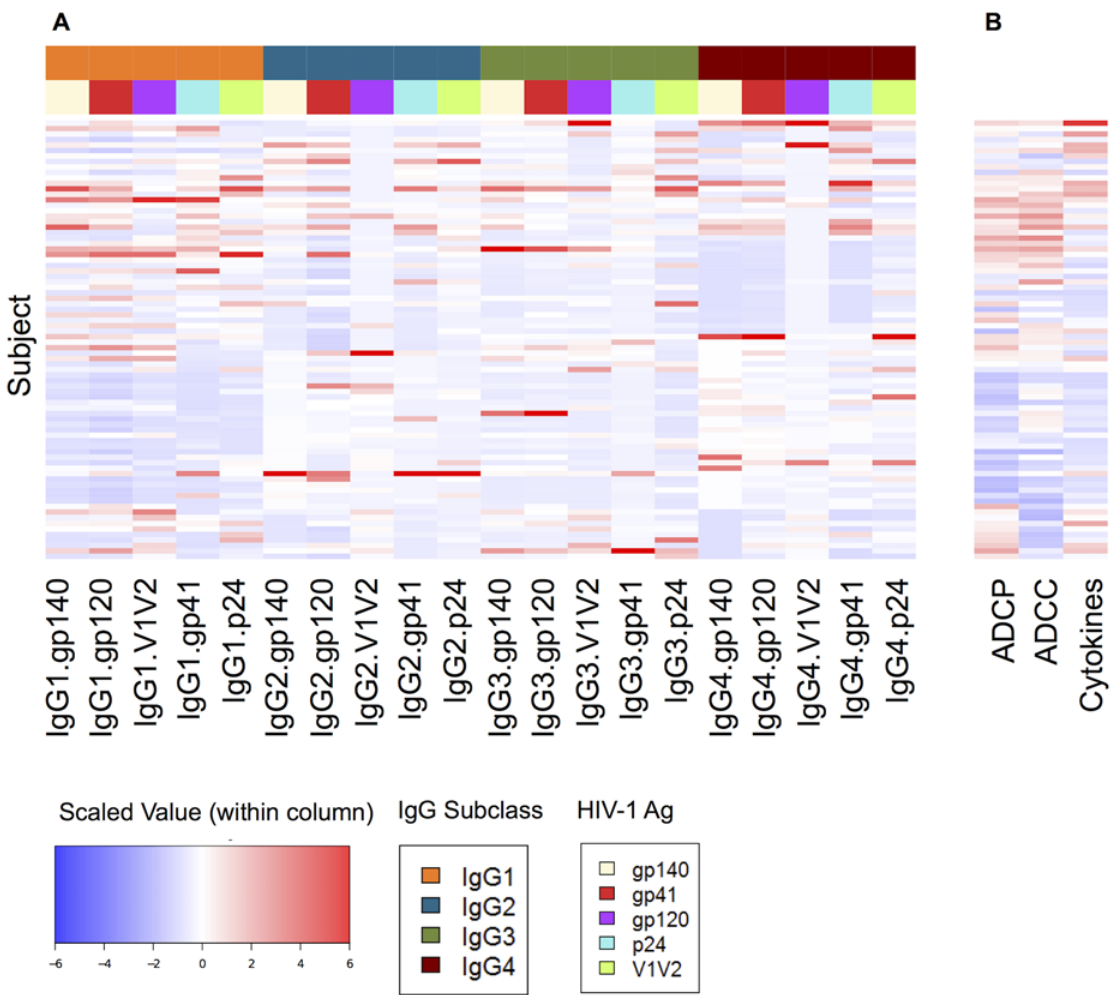
Fig 1. Input data. For each of 80 vaccinated subjects (rows), measurements of (A) 20 antibody features (4 IgG subclasses with 5 antigen specificities) and (B) 3 effector functions. The heatmap colors indicate relative values within each column, standardized to a mean of 0, a standard deviation of 1, and truncated at 6 σ . Color blocks above the antibody feature columns indicate IgG subclass and antigen